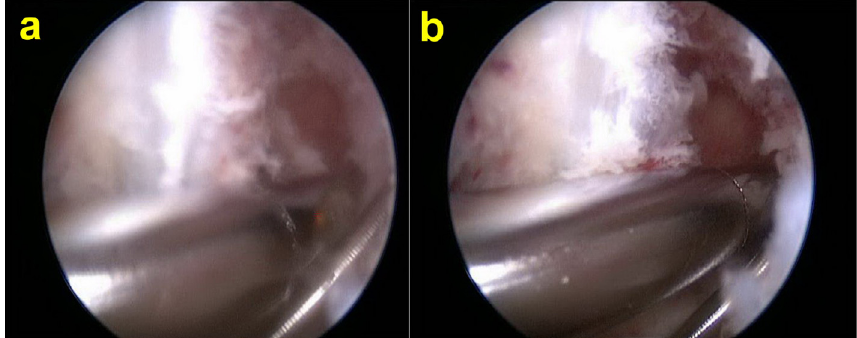
Figure 2. Debriding debris from posteromedial compartment. (a) Before debridement, (b) after debridement.